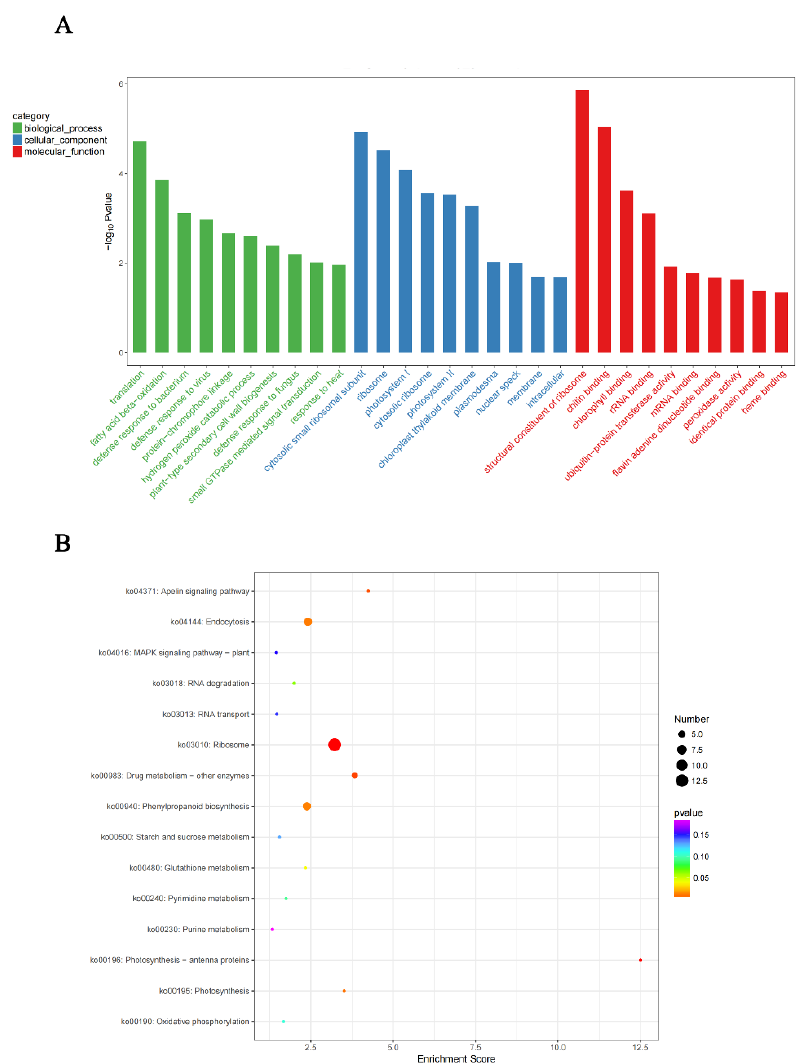
Figure 5. GO and KEGG analysis of candidate interaction proteins of GmNAC12 . ( A ) Diagram showing GO enrichment analysis of candidate interaction proteins of GmNAC12 . BP, biological processes; CC, cellular components; MF, molecular function. ( B ) KEGG analysis of candidate inter- action proteins of GmNAC12.